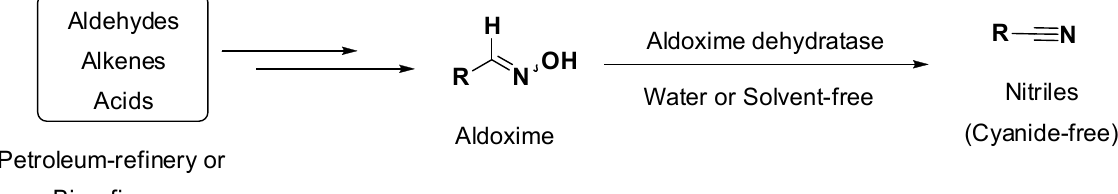
Figure 1. Selected examples of occurrence of nitriles with different uses as solvents, pharmaceuticals, food additives, or as polymer precursors [1–3].